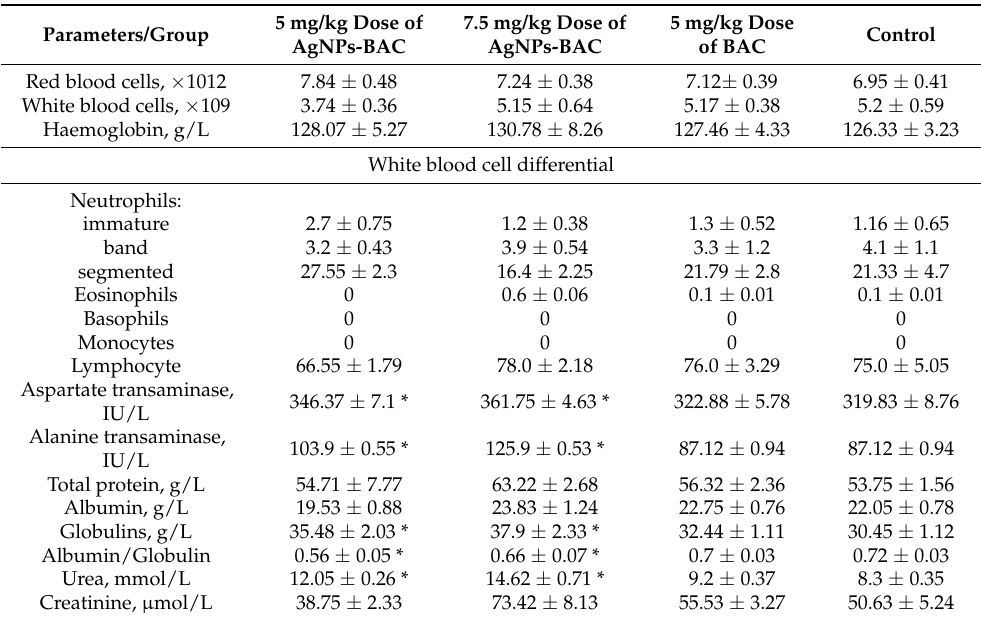
Table 1. Morphological and biochemical parameters of mice blood following single administration of high doses of AgNPs stabilized with benzyldimethyl[3-myristoylamine)-propyl]ammonium chloride monohydrate (AgNPs-BAC).